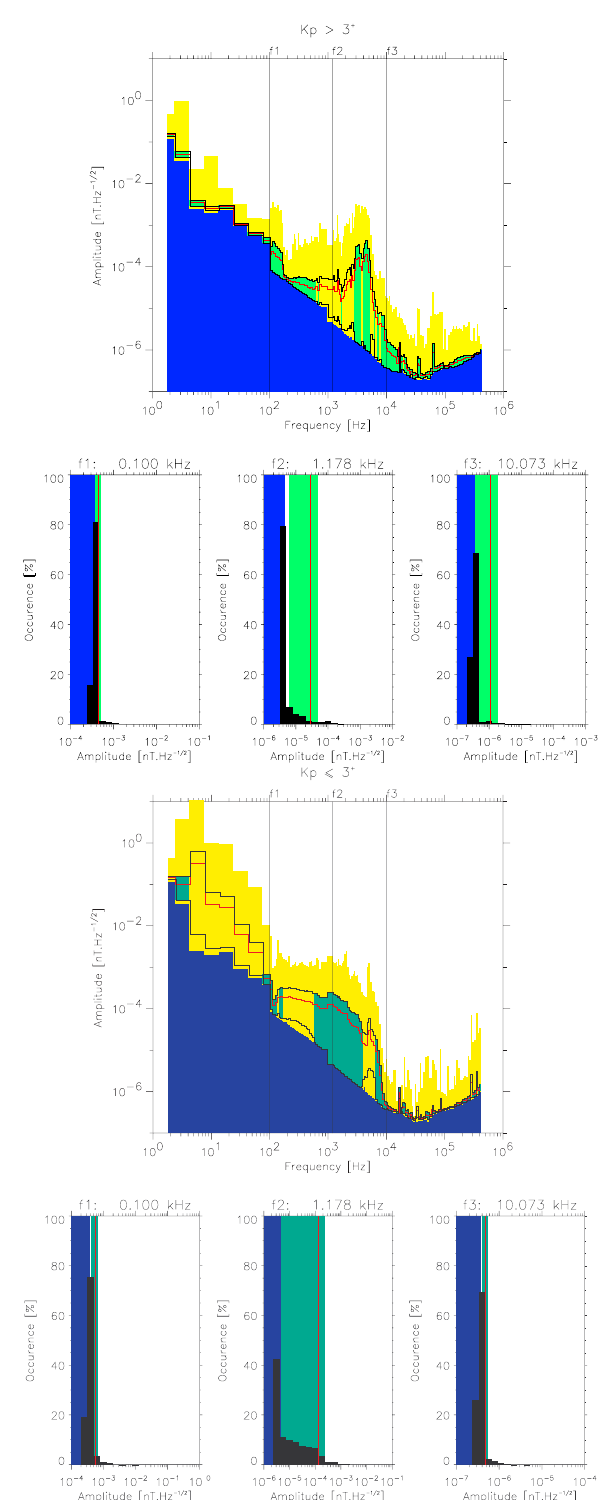
Fig. 2. Wide panels: Averaged amplitude spectrum (red lines) with the instrumental noise level (blue bars), the Gaussian confidence intervals (upper and lower black lines), the intervals in which the Gaussian confidence intervals make sense (green bars) and the extreme values recorded during the spacecraft mission (yellow bars). Small panels (three frequencies): Amplitude p.d.f. (black bars) with the computed average value (vertical red line), the Gaussian confidence interval (green bars, shown even if it does not make sense) and the instrumental noise (blue